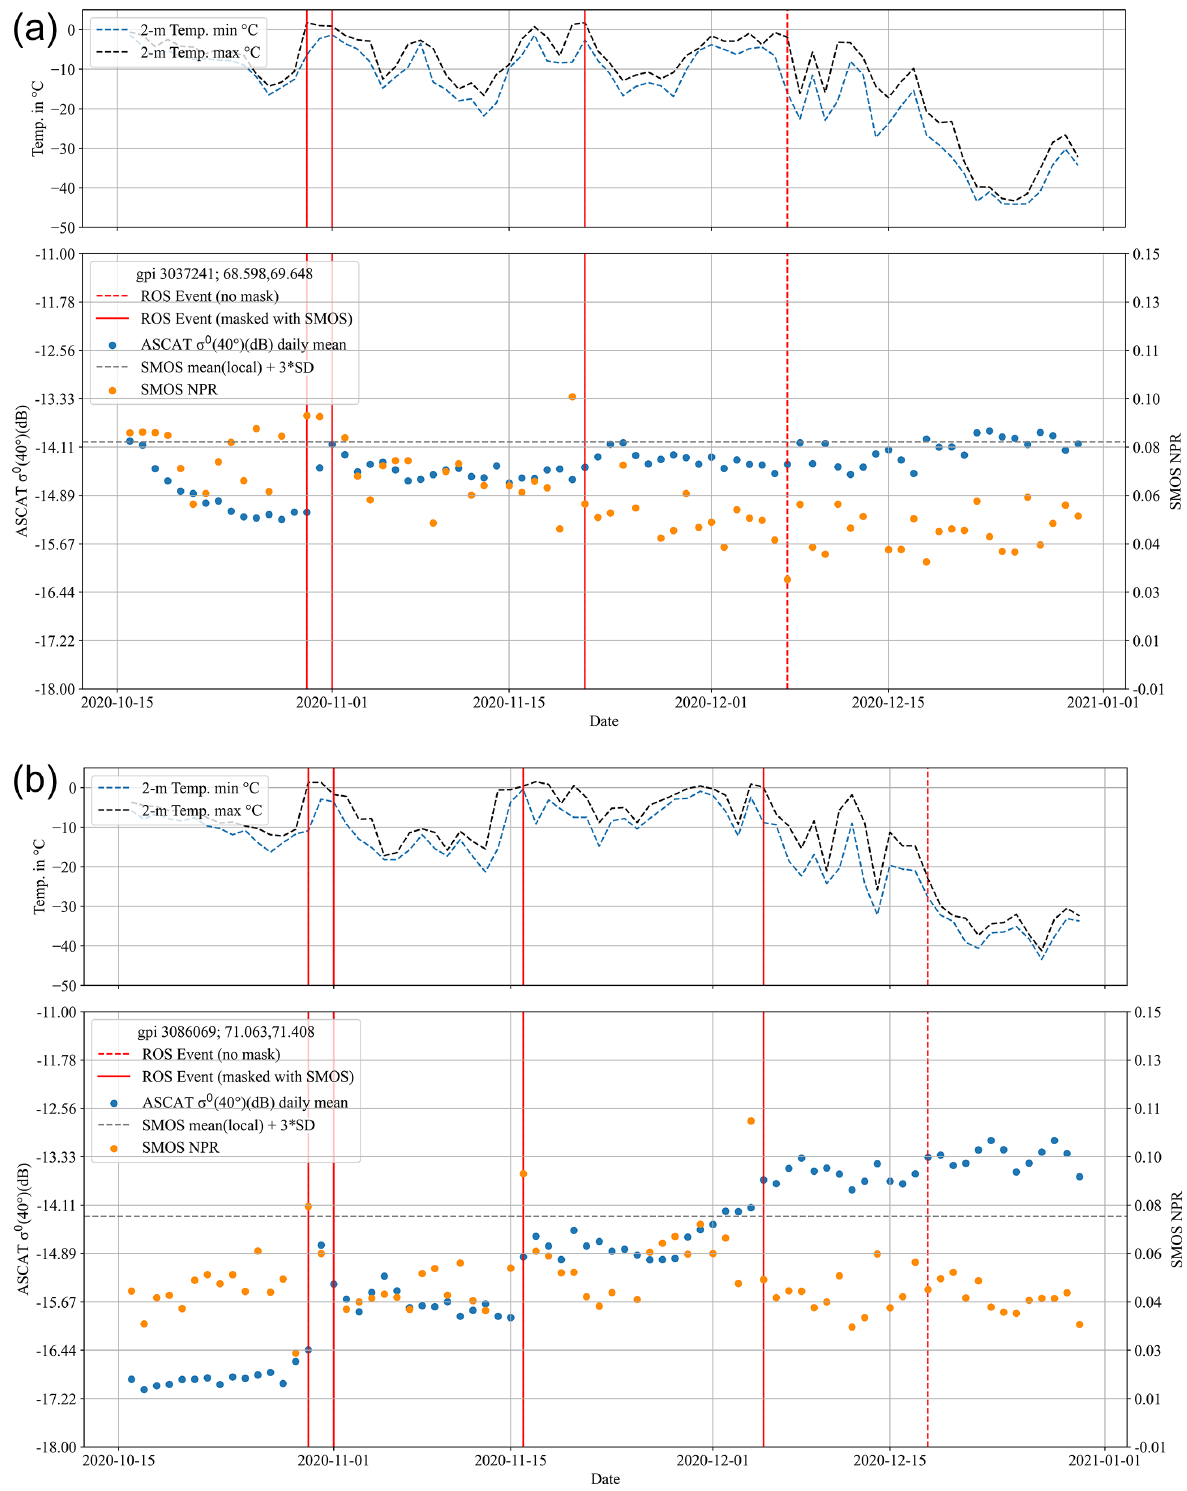
Figure 4. Time-series examples for the event series in early winter 2020 on the Yamal Peninsula: (a) south no. 3 and (b) north no. 18. For location see Fig.